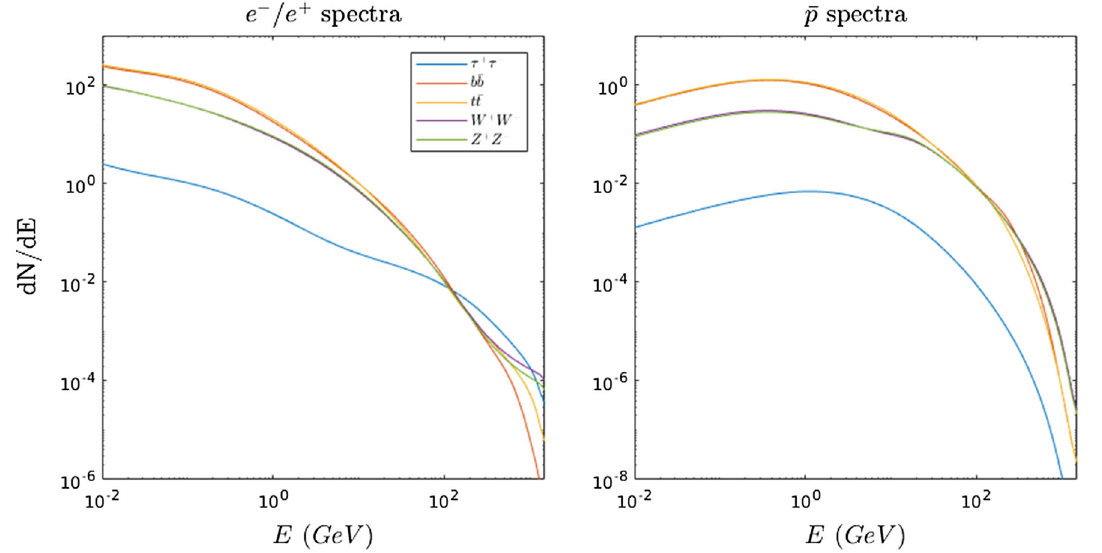
Fig. 4 The positron/electron and antiproton spectra produced by the annihilation of two dark matter particles with mass 1.5